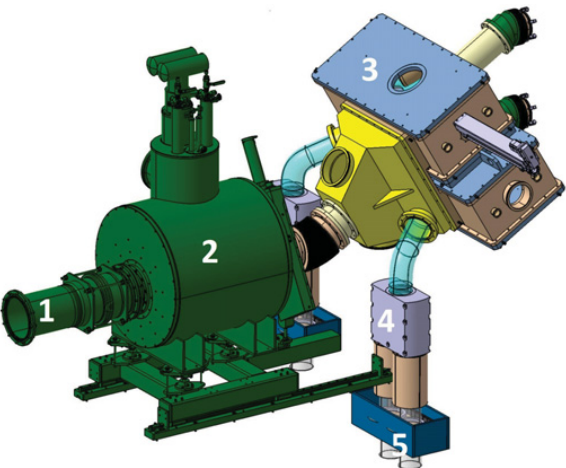
Figure 4. UCN system. The UCN are supplied from the UCN source (1). The UCN are polarized after passing a 5T superconducting polarizer magnet (2). The polarized UCN are guided into the UCN chambers through a UCN switch (3). After the measurement cycle, spin analyzers (4) select separate spin states of the UCN and guide them to separate neutron detectors for each spin state. Only the detector mount points are shown at